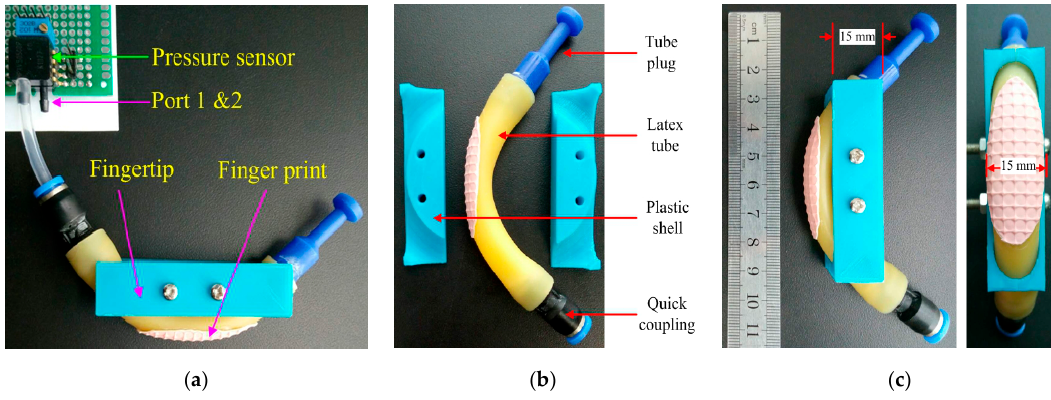
Figure 1. The pneumatic tactile sensor. ( a ) the configuration of the sensor with the fingertip connected to the MPXV5050DP; ( b ) the components of the fingertip; ( c ) the size of the fingertip.